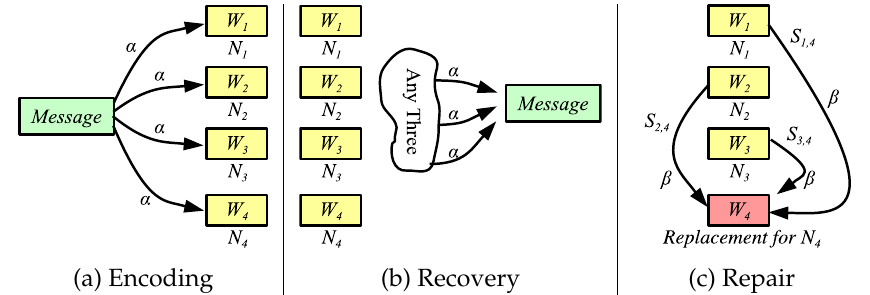
Figure 1. The regenerating code problem with ( n , k , d ) = ( 4,3,3 ) .